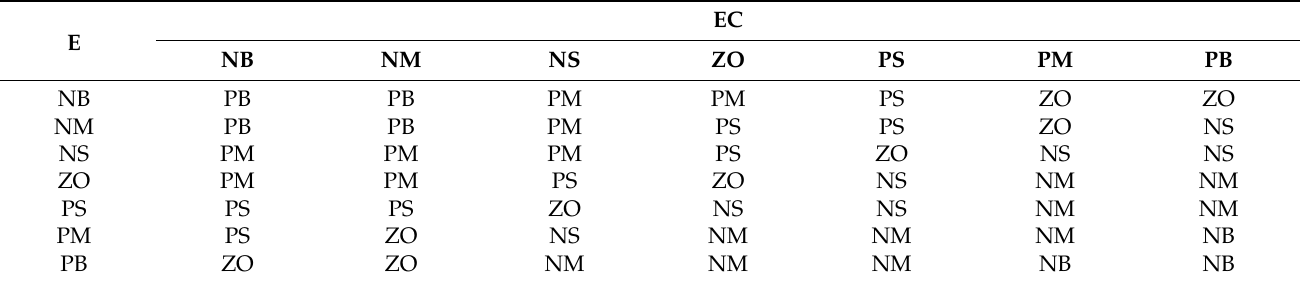
Table 1. The fuzzy control rules of proportional coefficient.